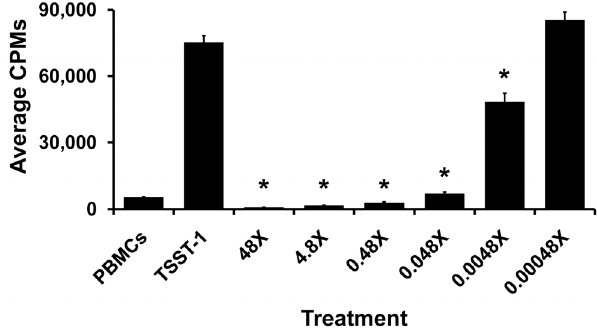
Figure 8. E.faecalis MN1 low molecular weight fraction inhibits TSST-1-induced T cell proliferation. E. faecalis MN1 supernate was treated with ethanol (80% final concentration), insoluble material was removed by centrifugation, soluble material (referred to as the low molecular weight fraction) was concentrated 480 times relative to the original culture fluid, and dilutions incubated with human PBMCs and TSST-1 (1 m g/well) in a superantigenicity assay to assess the ability of secreted factors to inhibit TSST-1-induced T cell proliferation. The PBMC control shows the average CPMs for PBMCs alone and TSST-1 shows the average CPMs for TSST-1 alone. Treatments 48 6 to 0.0048 6 were significantly different from TSST-1 alone by individual Student’s t tests (*p , 0.001). Three independent wells for each treatment were assayed for cell viability, and viability in all cases was . 95%.